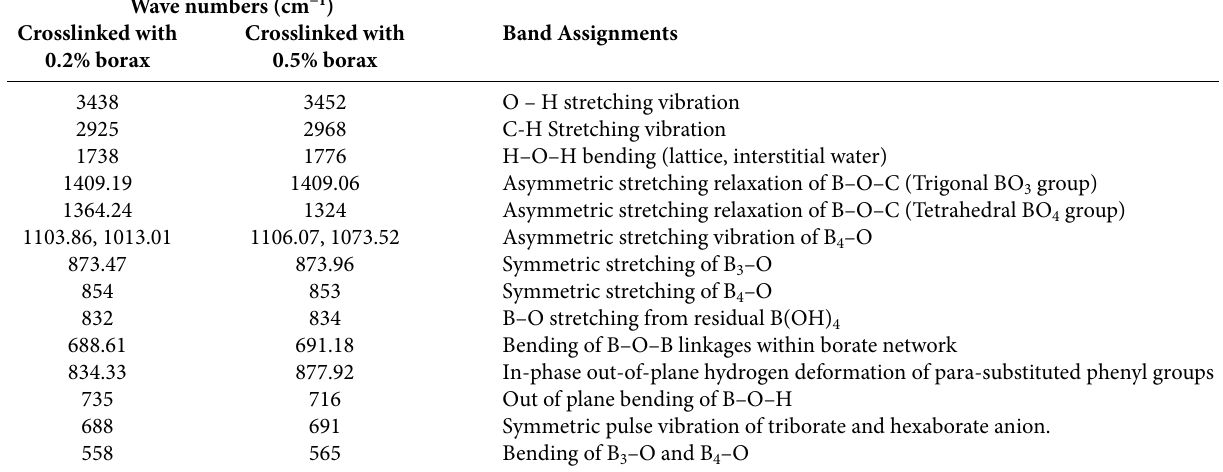
Table 1. Principal band assignments of FTIR spectra over wave number 4000-400 cm